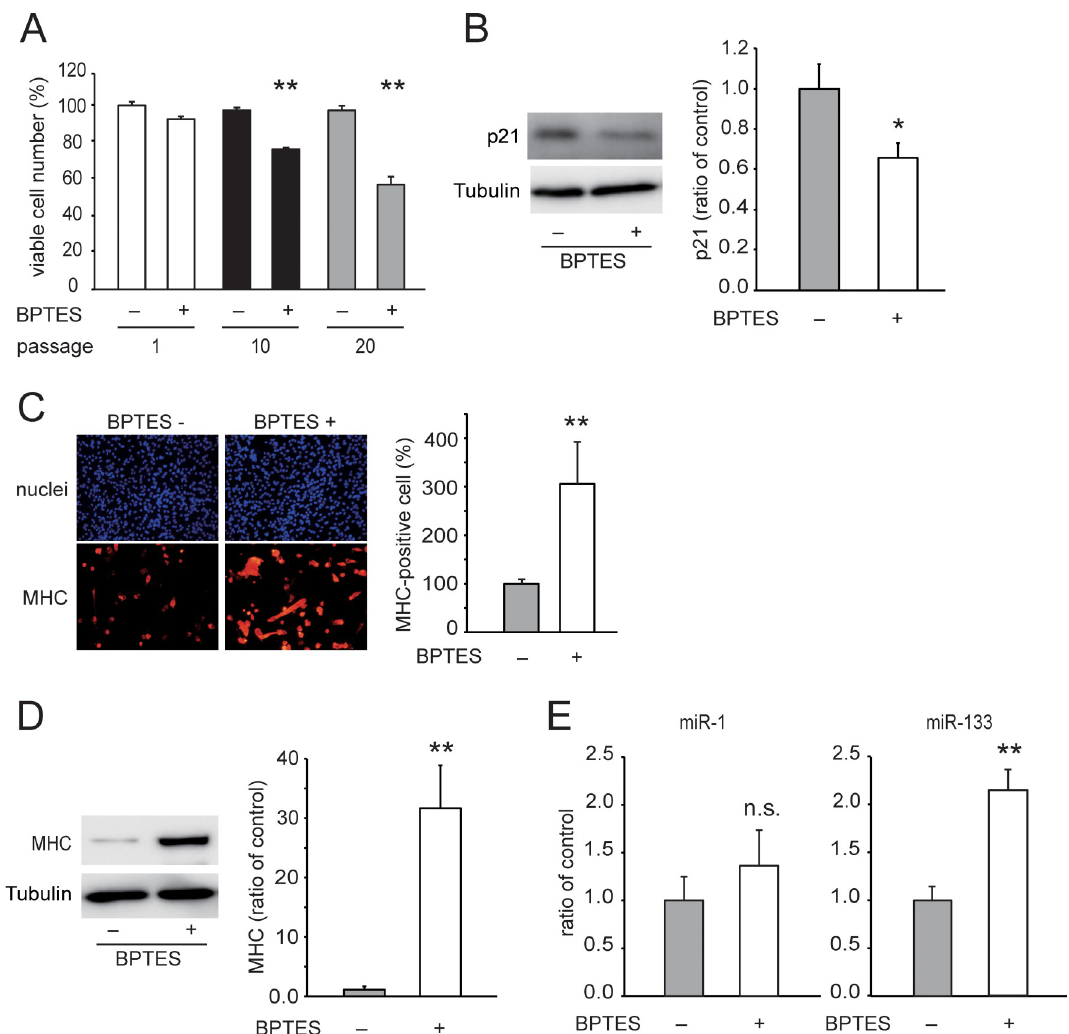
Fig 6. Effect of senolysis on the differentiation capacity of replicative senescent C2C12 cells. Panel A shows the relative cell number after treatment with BPTES or 1% DMSO for 48 h following repeating passage once (passage 1), 10 times (passage 10), or 20 times (passage 20). Data are presented as means ± SE (n = 8 wells). �� P < 0.01 vs. 1% DMSO at each passage number (Tukey–Kramer test). Panel B shows representative blots of p21 and tubulin, and quantitative data normalized with the tubulin in cells surviving BPTES treatment following repeated passage 20 times. Data are presented as means ± SE (n = 4 dishes). � P < 0.05 (t-test). Panel C shows representative myosin heavy chain (MHC) immunostaining images and the number of MHC-positive cells. Cells that survived BPTES treatment following repeated passage 20 times were subjected to differentiation for 7 days and were stained with DAPI (blue fluorescence) and an antibody against MHC (red fluorescence). Data are presented as means ± SE (n = 7 dishes). �� P < 0.01 (t-test). Panel D shows representative MHC and tubulin blots and quantitative data normalized with tubulin in cells surviving BPTES treatment following repeated passage 20 times. Data are presented as means ± SE (n = 4 dishes). �� P < 0.01 (t-test). Panel E shows miR-1 and miR-133a levels in cells surviving BPTES treatment following repeated passage 20 times. Data are presented as means ± SE (n = 4 dishes). �� P < 0.01